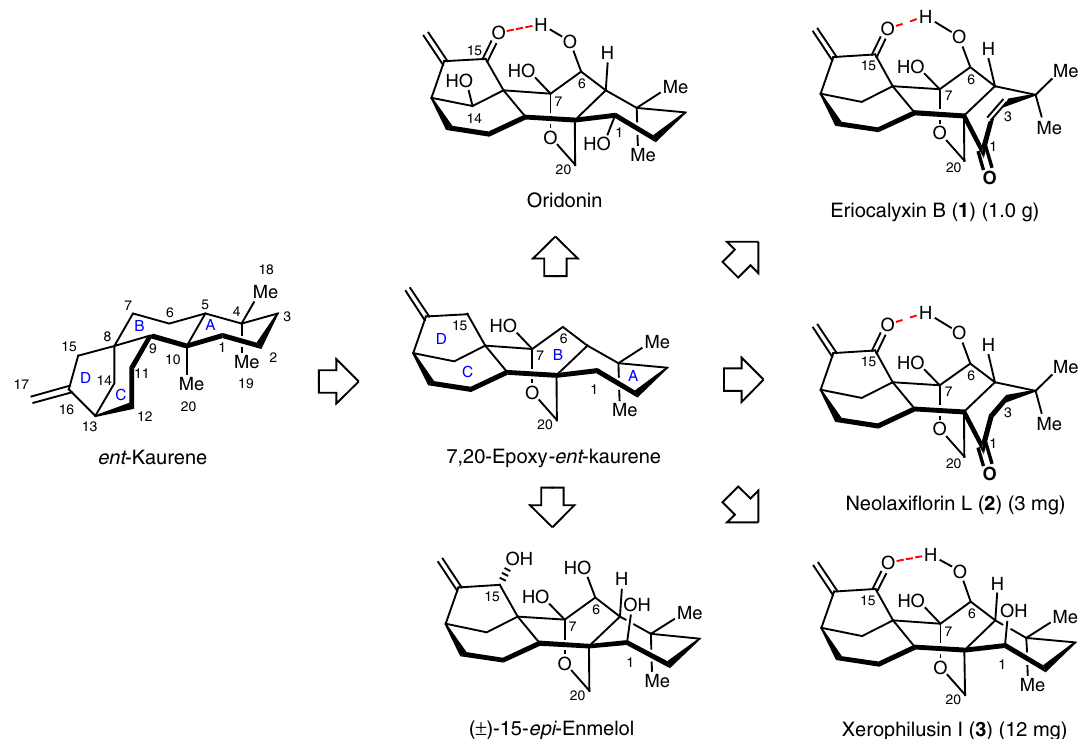
Fig. 1 Representative Isodon 7,20-epoxy- ent -kauranoids. This subclass of Isodon diterpenoids features a C7-C20 hemiketal bridge, boat conformations of the B and C rings, and intramolecular hydrogen bonding between the C6 β -hydroxyl and the C15 carbonyl. The numbers in parenthesis indicate the amount that isolated from 10 kg of dried leaves of I. eriocalyx var. laxi fl ora